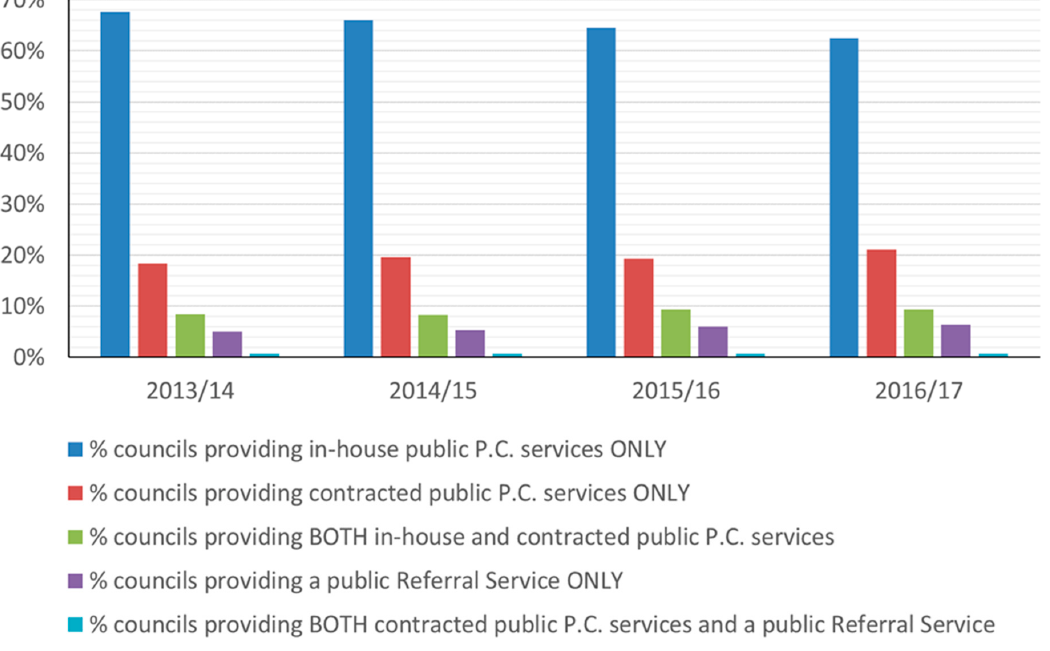
Figure 9. The proportion of UK councils providing each type of public pest control service out of all the councils providing a service in 2013 / 14 ( n = 299), 2014 / 15 ( n = 300), 2015 / 16 ( n = 299), and 2016 / 17 ( n = 299).